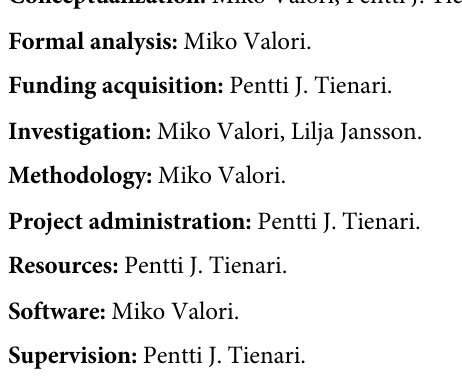
S2 Fig. Age effect. Age vs number of exonic somatic mutations for all samples. S1 Table. Patient details. Patients’ demographic features. S2 Table. Control details. Control participants’ demographic features. S3 Table. Panel gene list. List of genes included in the NGS capture panel. S4 Table. Sequence context noise. Mean background noise tabulated by sequence context and base change. S5 Table. Variant calling filters. List of filtering criteria used during somatic variant calling. S6 Table. Nonsynonymous mutations. All nonsynonymous somatic mutations detected in the study. S7 Table. Amplicon counts. Targeted amplicon sequencing results. S8 Table. Synonymous mutations. The synonymous mutations detected in the study.